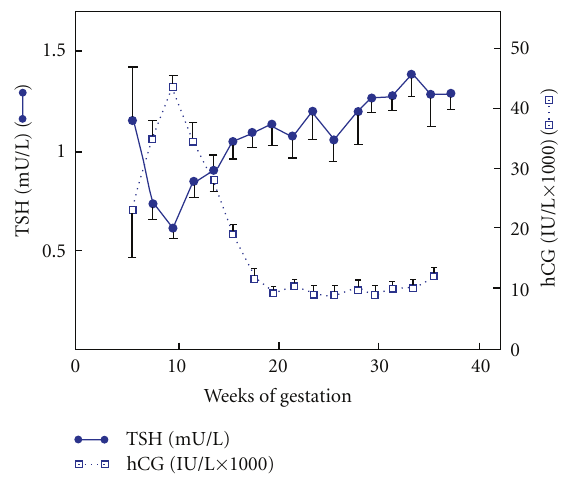
Figure 3: Serum hCG and TSH as a function of gestational age Glinoer et al.